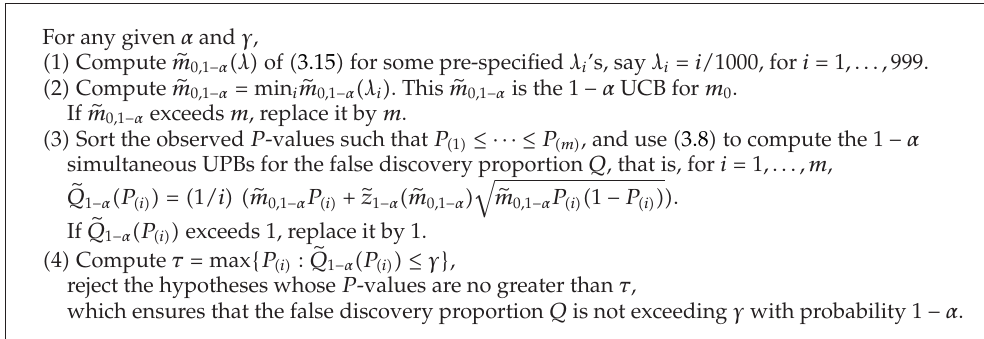
Algorithm 1: Compute the simultaneous UPBs for the false discovery proportion and the UCB for m 0